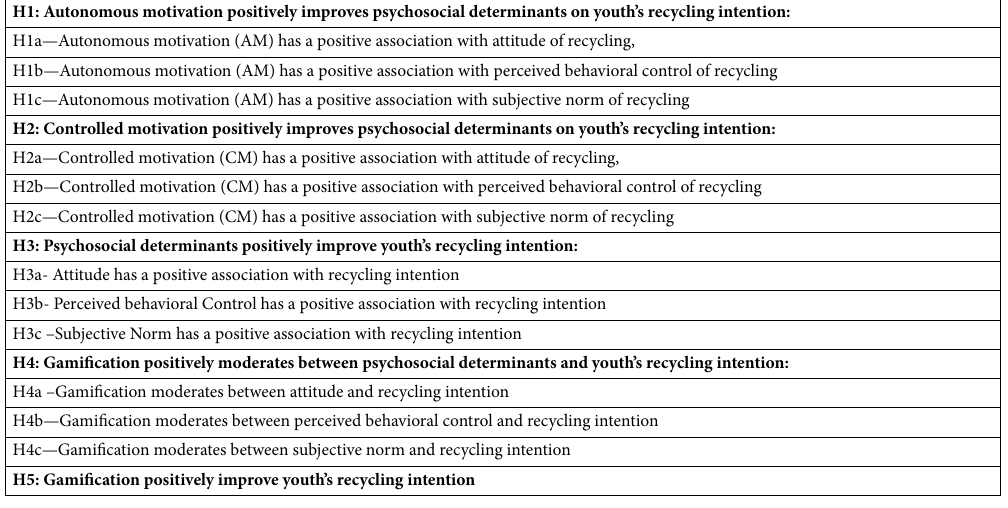
Table 1. Research hypotheses.